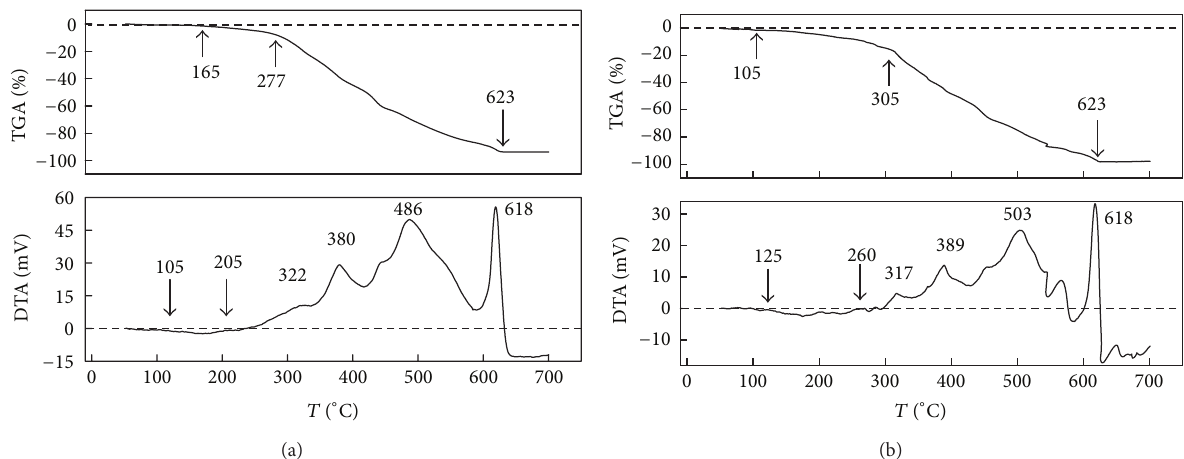
Figure 8: TGA and DTA thermograms of (a) the exposed microcapsule and (b) the unexposed microcapsule, at heating rate of 10 ∘ C/min.